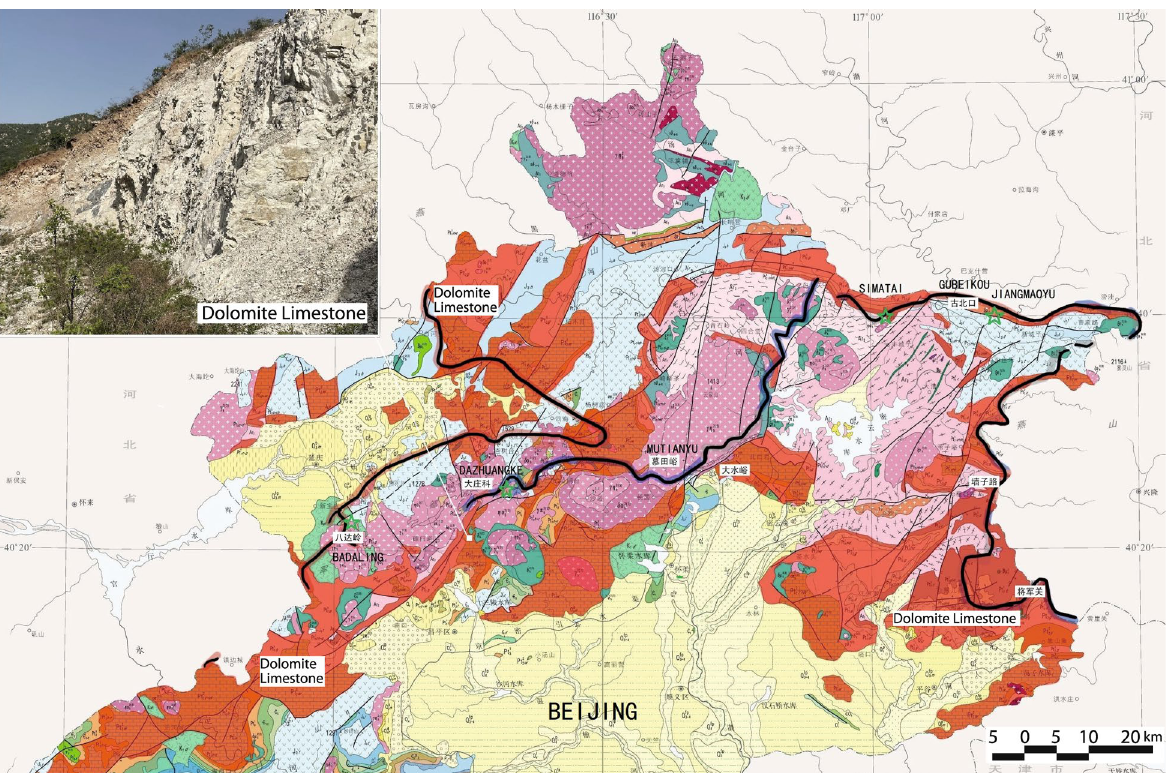
Fig. 13 Location of the Ming Great Wall (simplified) with dolomite limestone occurrences (red orange) (Source: geological map based on http:// drr. ikcest. org/ map/ m02c3? fulls creen 1& gson # 11/ 39. 2065/ 116. 5624) = =